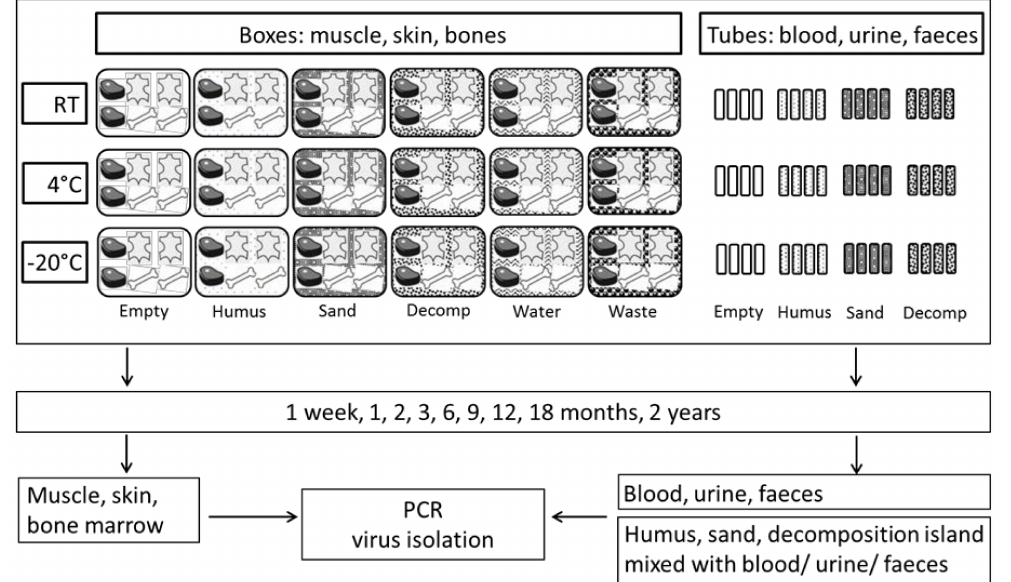
Figure 1. Study design. Storage of the samples of three domestic pigs (DP1–3) and three wild boar (WB1–3) alone (empty) or on di ff erent matrices: humus, sand, decomposition island (decomp), water or